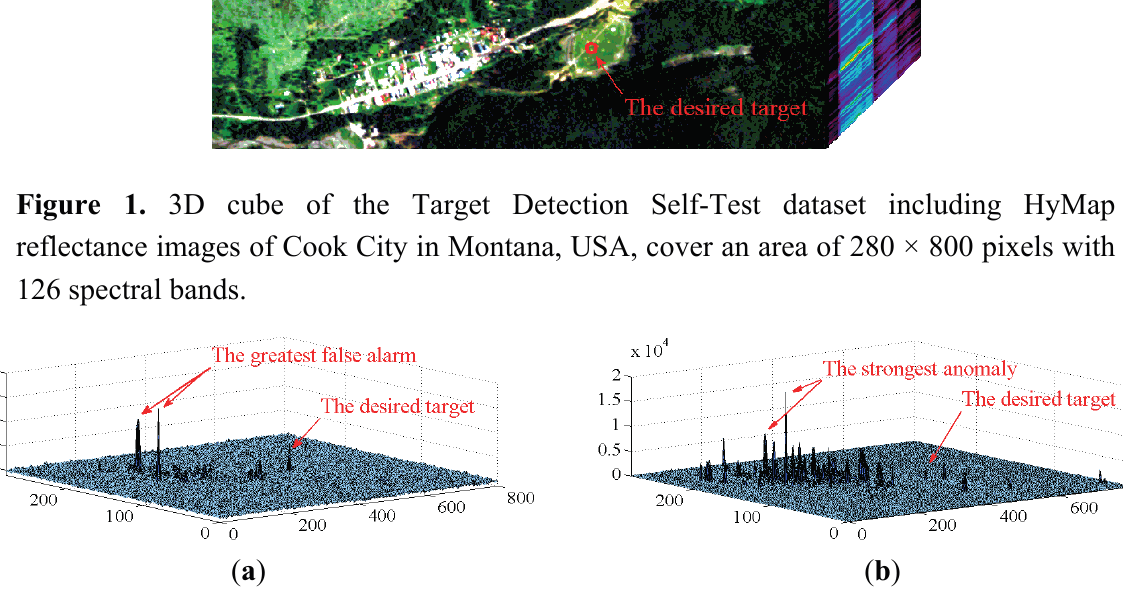
Figure 2. Hyperspectral image target detection results, where ( a ) is CEM result and ( b ) is RX